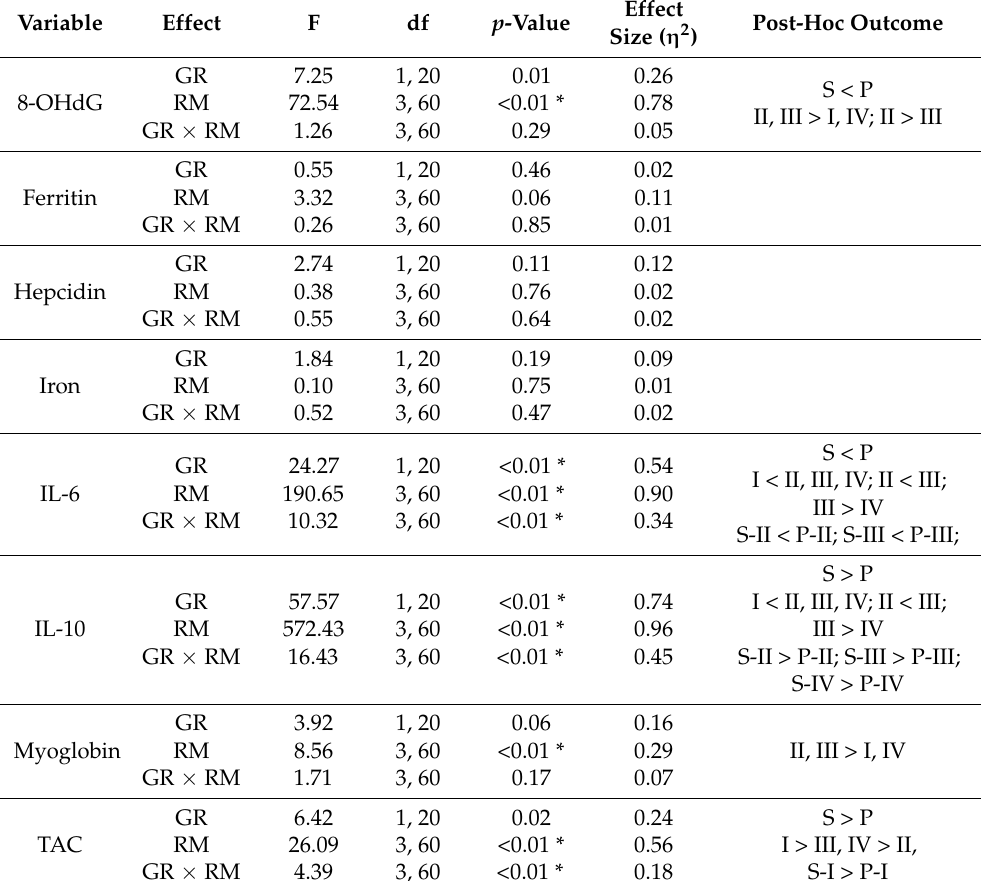
Table 5. Two-factor ANOVA with repeated measures (2 groups × 4 time points) † of the serum levels of inflammatory markers induced by maximal aerobic effort (MAE) after 90 days of supplementation with a lyophilizate of black chokeberry